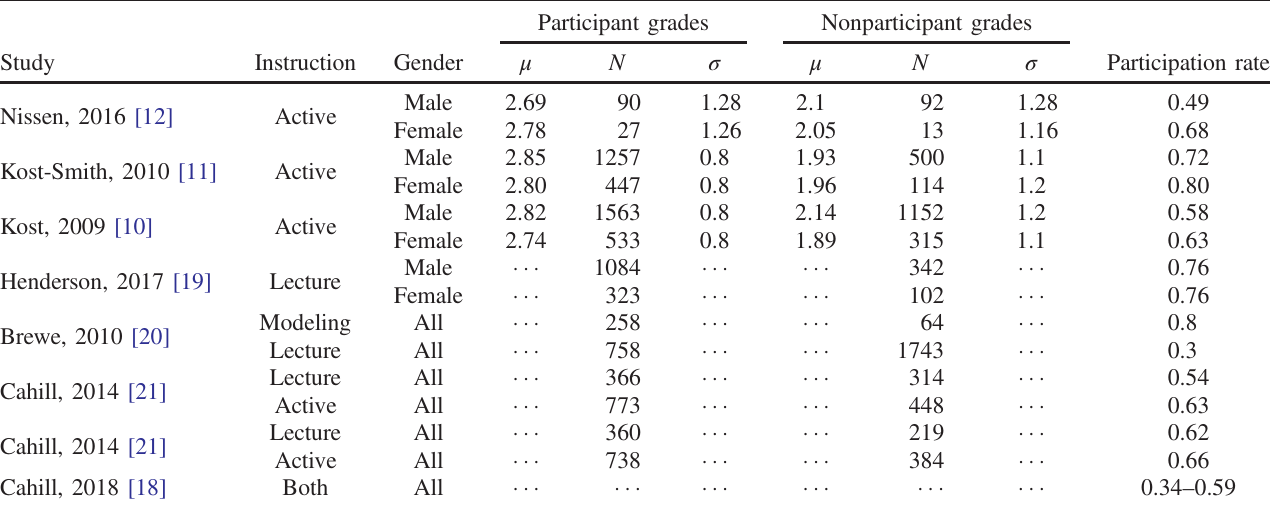
TABLE I. Participation rates and descriptive statistics for students ’ grades from prior studies published in Physical Review Physics Education Research. Descriptive statistics include mean ( μ ), sample size ( N ), and standard deviation ( σ ). Grades are in GPA units on a 0 – 4